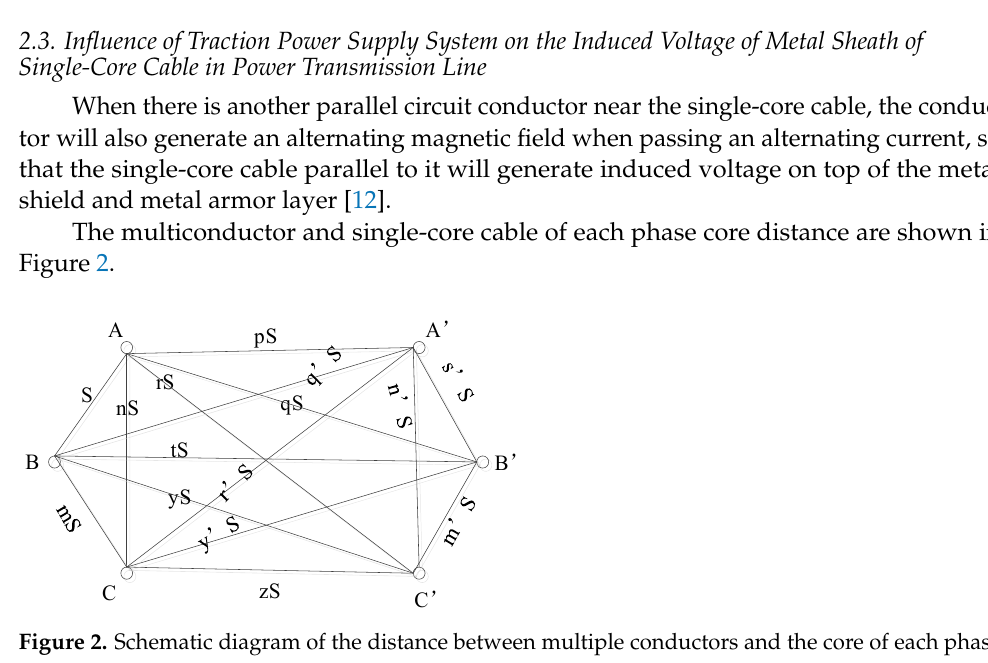
Figure 2. Schematic diagram of the distance between multiple conductors and the core of each phase of a single-core cable. of a single-core